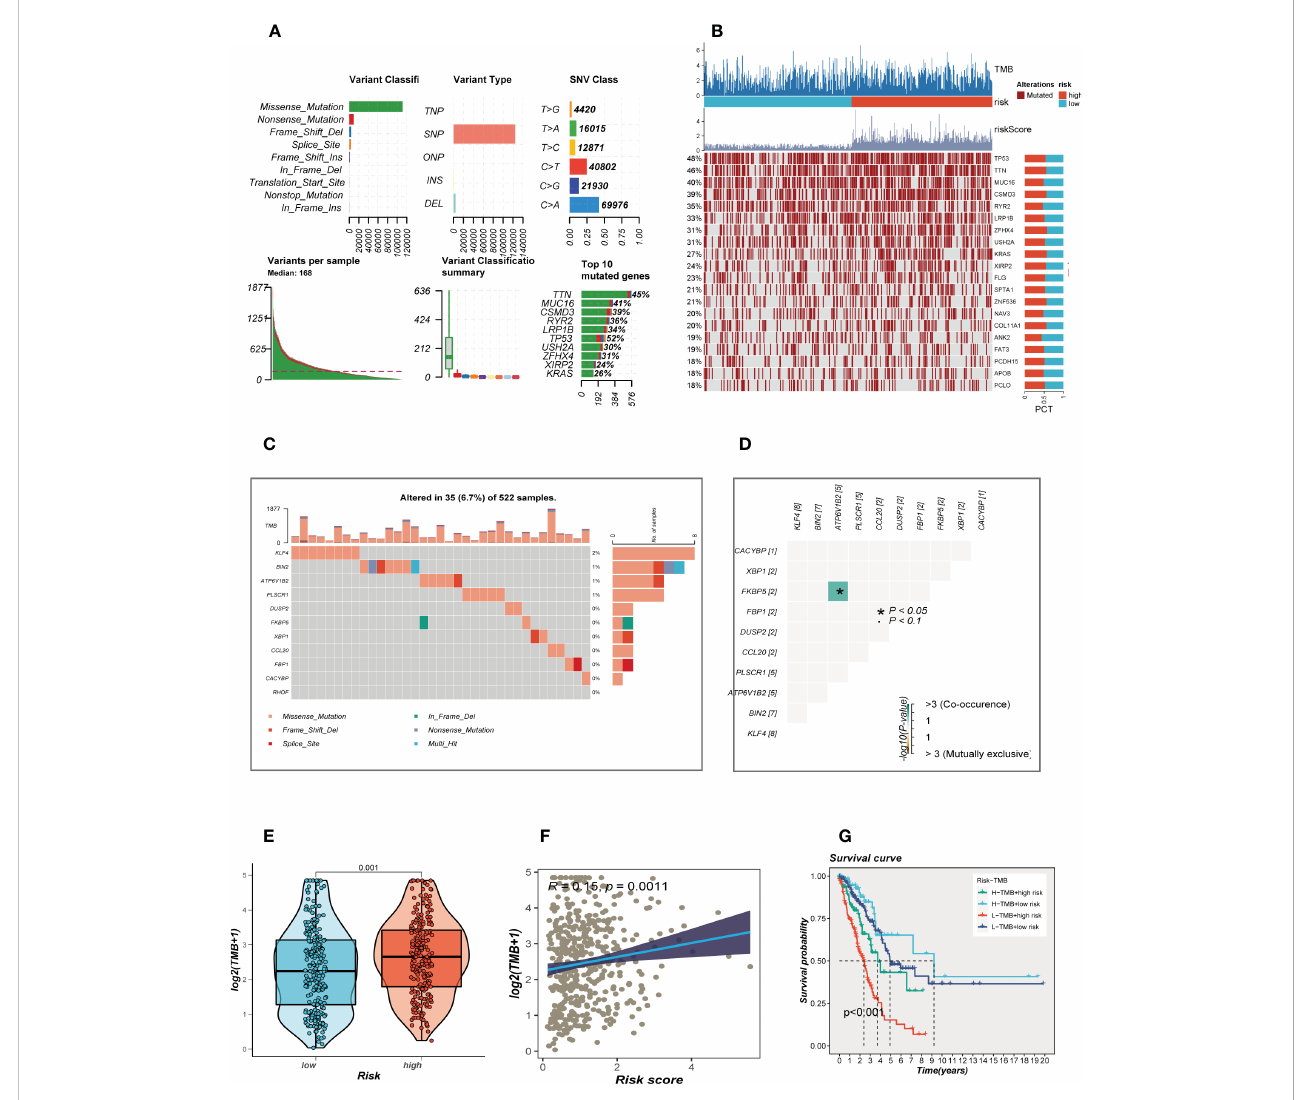
FIGURE 6 Landscape of LUAD sample mutation pro fi les. (A) Description of the statistical measurement mutation details, among which the most common mutation type was a missense mutation. SNP occupied an absolute proportion compared with insertion or deletion, and C>A occurred more frequently than in other classi fi cations of forms. The horizontal histogram listed the top 10 mutated genes in melanoma. (B) Mutation landscape of the top 20 genes with mutation frequency in differential risk subgroups. (C) Mutation landscape of model genes. (D) Co-mutation or co-exclusion relationships among model genes. (E) Comparison of tumor mutation burden (TMB) between different risk groups. (F) Correlation analysis between risk score and TMB. (E) Survival differences for four different subgroups (H-TMB+high-risk, H-TMB+low-risk, L-TMB+high-risk, and